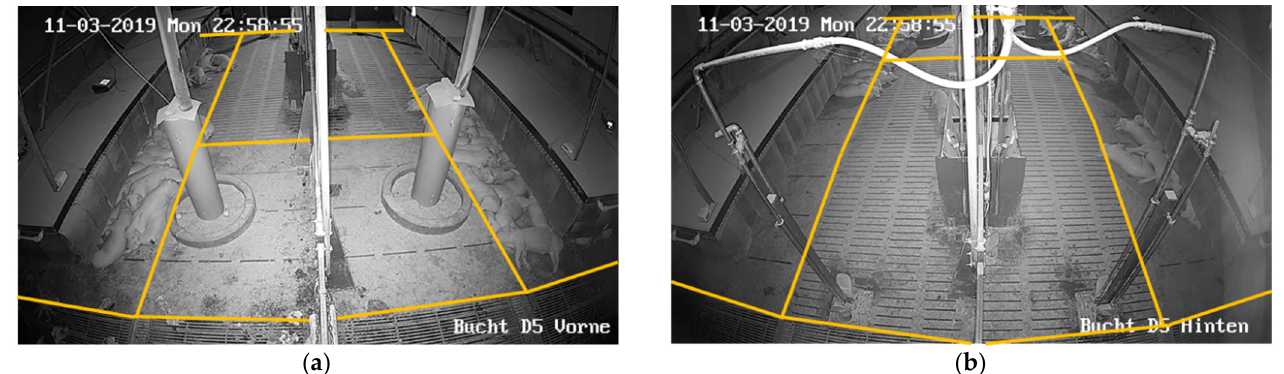
Figure 2. Screenshots of ( a ) the front and ( b ) back video camera in compartment D5 with the five segments in each pen to determine the lying behavior and the fouling.